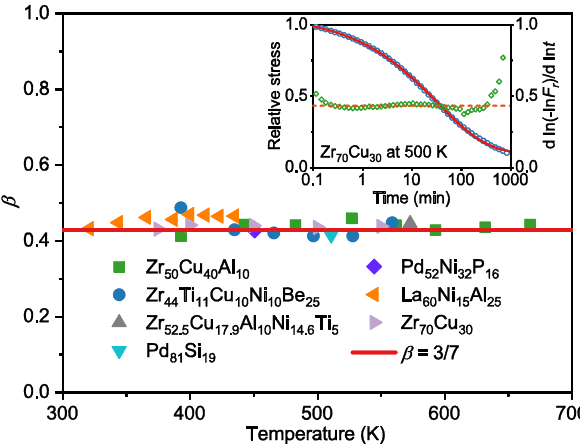
Fig. 3 | Stress-relaxation of various metallic glasses. β values in various MGs at temperaturesbelow T g obtainedby fi ttingthestressrelaxationcurvesmeasuredin experiments. The solid horizontal line (red) marks β =3 = 7. Inset shows a typical stress relaxation of Zr 70 Cu 30 MG ribbon at 500K measured in experiments with a strain of 0.005 applied to MG samples. Red solid curve is the fi tting by KWW (cid:1) (cid:3) = dln t is also shown in the inset with the value function with β =3 = 7. dln (cid:2) ln F r closeto3/7.Resultssuggestthatthe β =3 = 7dynamicsignatureisacommonfeature in physical aging below T g for hyperquenched